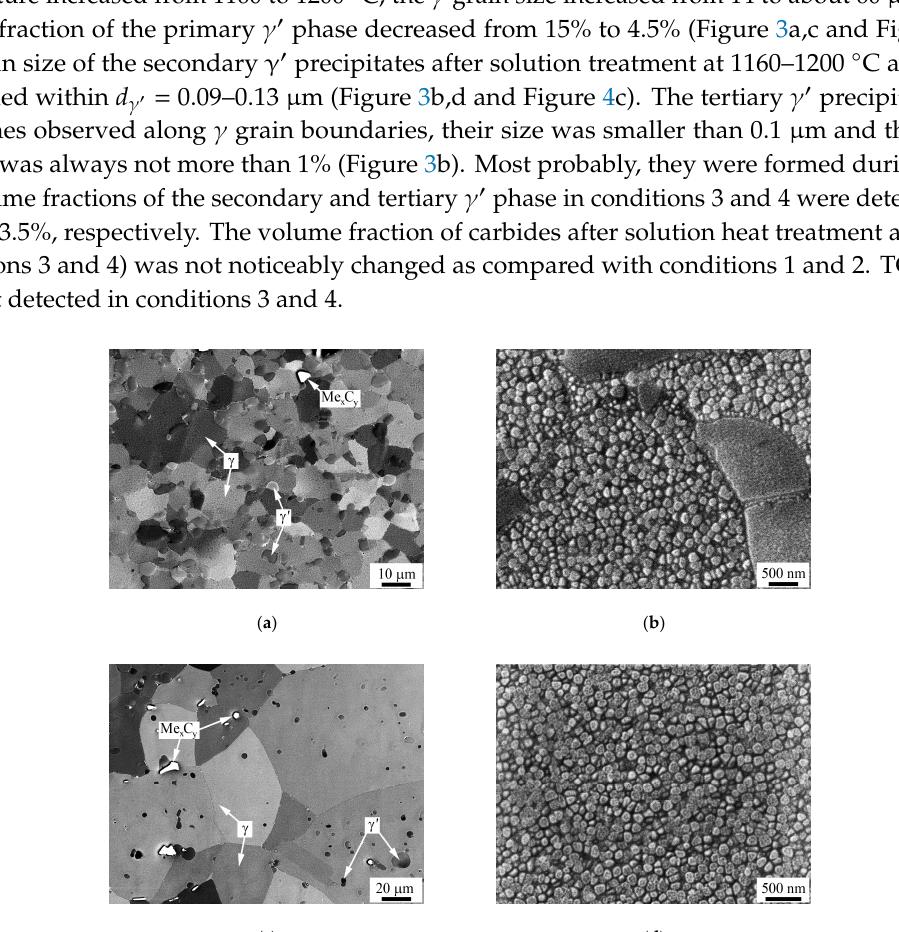
( a ) ( b ) ( c ) Figure 4. The dependencies of ( a ) the γ grain size, ( b ) the volume fraction of the primary γ ′ phase and ( c ) the size of the secondary γ ′ precipitates obtained after solid solution treatment at different temperatures followed by ageing.